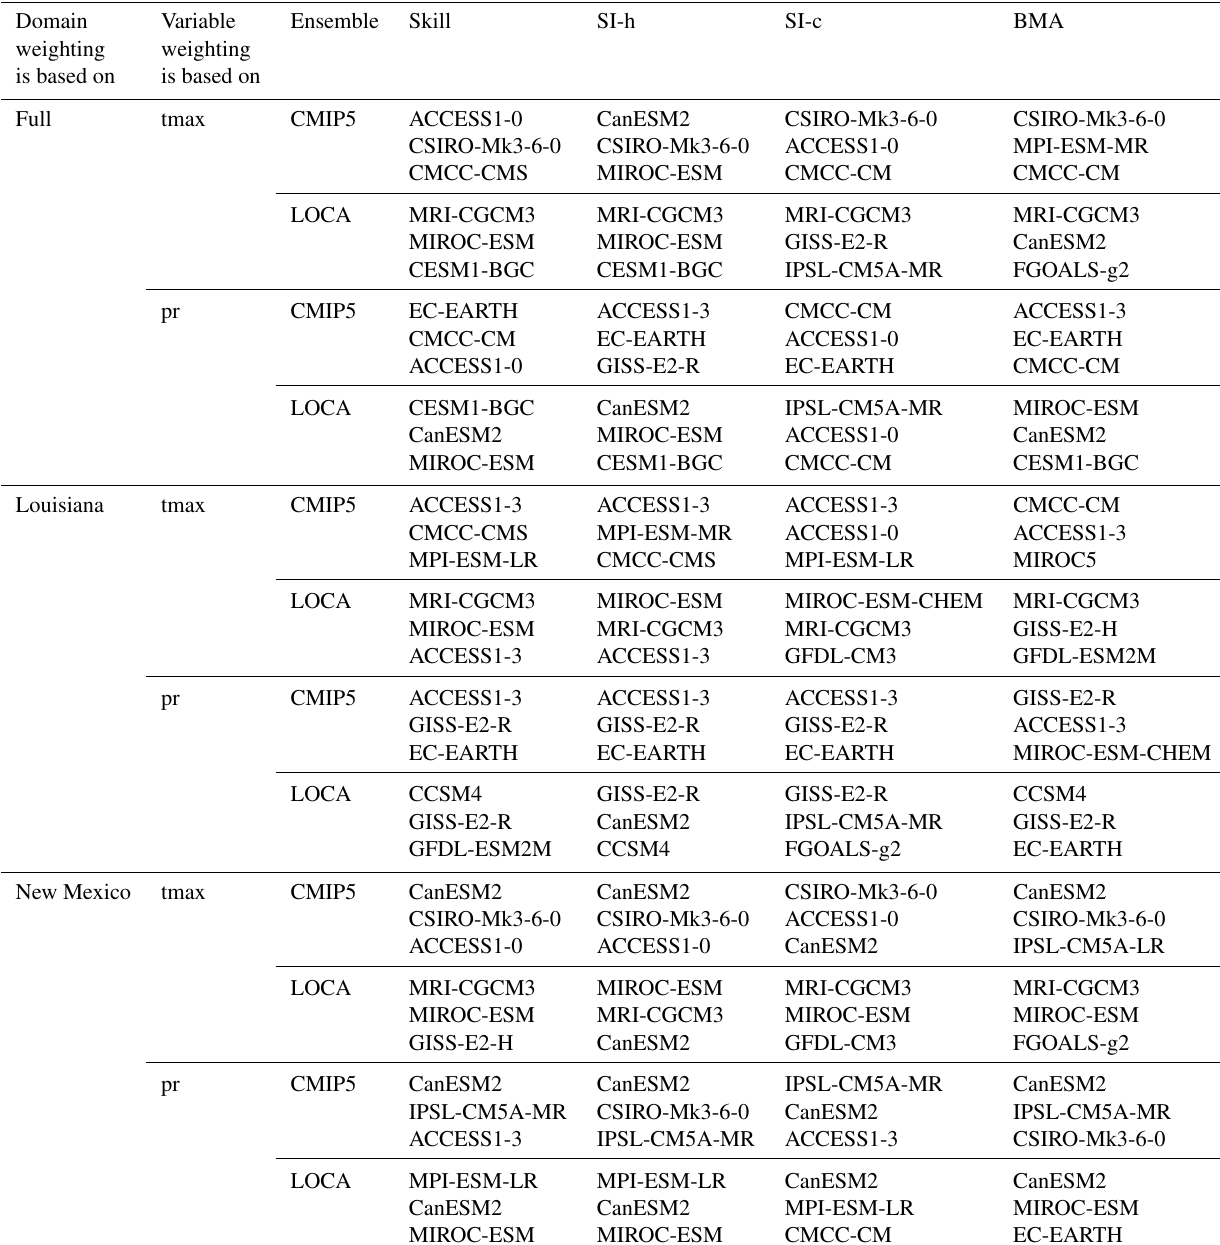
Table 1. Top three highest weighted models from each of the 48 weighting